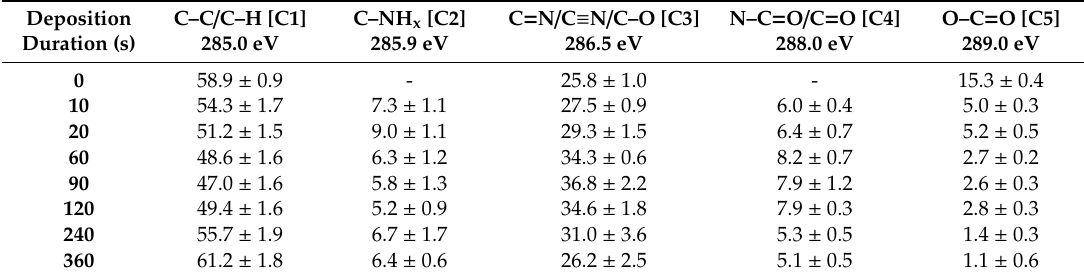
Table 2. Summary of XPS high resolution C1s peak deconvolution for untreated and